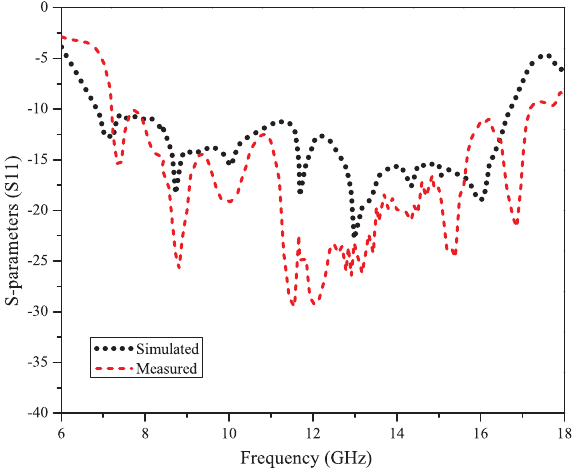
Figure 9. Prototype of the proposed hybrid waveguide-SSPP ( a ) corrugated SSPP design, ( b ) waveguide transition, and ( c ) proposed final design.